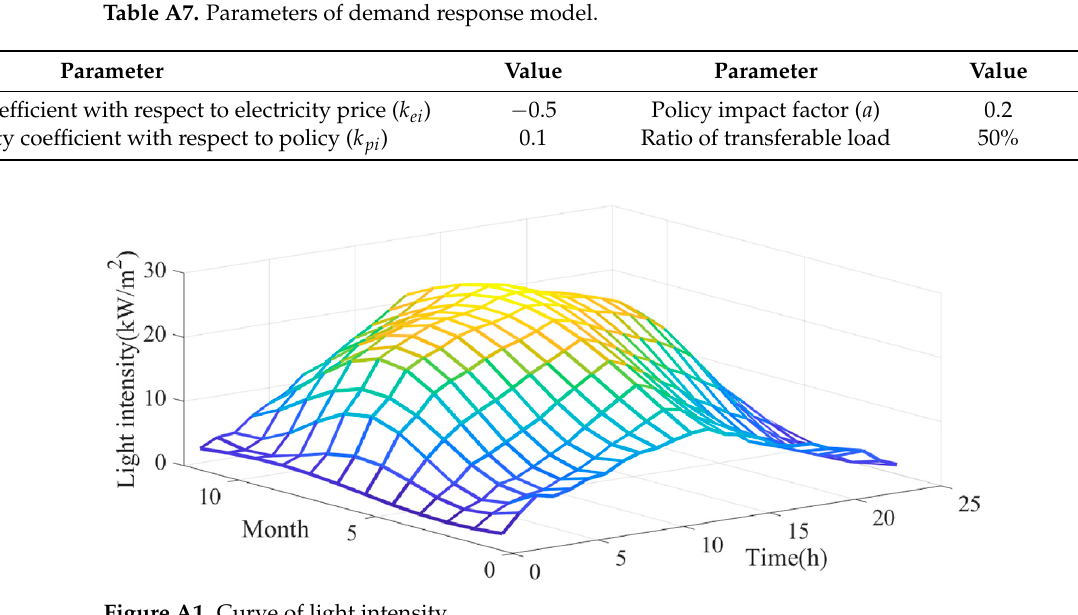
Figure A1. Curve of light intensity.